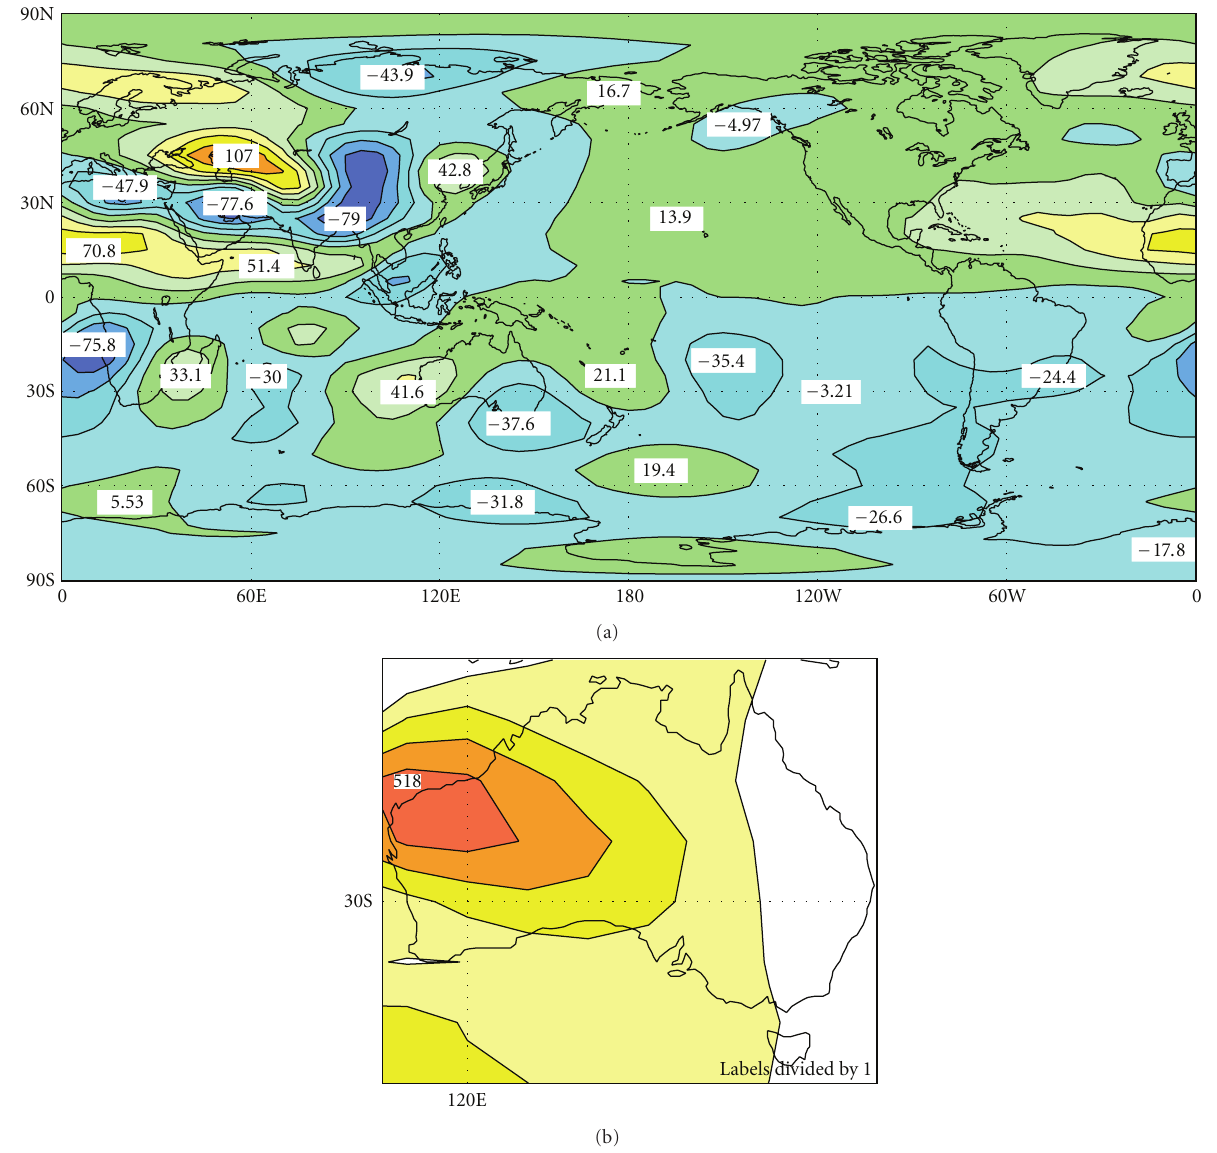
Figure 7: As in Figure 4 but for the global upper-level streamfunction (a) and the upper-level divergence in the Australian region (b) for the leading intraseasonal oscillation mode, mode 35, for the July 1975–94 basic state.